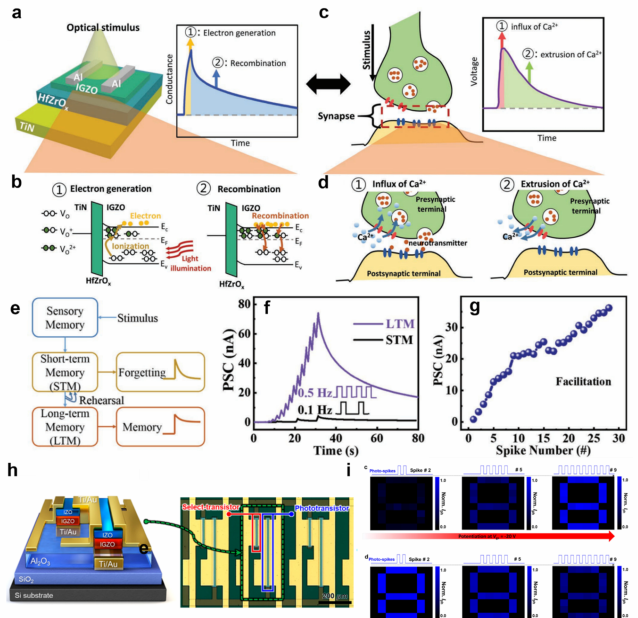
Figure 11. ( a ) Schematic device structure of the photonic synapse and optical responses of IGZO-based transistor; ( b ) Schematic mechanisms of an optical response in IGZO-based transistors; ( c ) Schematic illustrations of biological synapses and their action potential; ( d ) Schematic illustrations of synaptic transmission in biological synapses (adapted from [133] with permission from the John Wiley and Sons); ( e ) Typical memory model describe STM and LTM behavior; ( f ) STM and LTM behavior under changed frequency of UV light pulse (STM: freq. = 0.1 Hz, LTM: freq. = 0.5 Hz); ( g ) Changed synaptic weights for each pulse emulating the neural facilitation behavior (adapted from [134] with permission from the John Wiley and Sons); ( h ) Schematic cross-section of a pixel in the NAPISA and optical microscope image of a pixel; ( i ) Mapping image of NAPISA with visual memorizing under a potentiation mode and visual forgetting under a depression mode (adapted from [135] with permission from the American Chemical